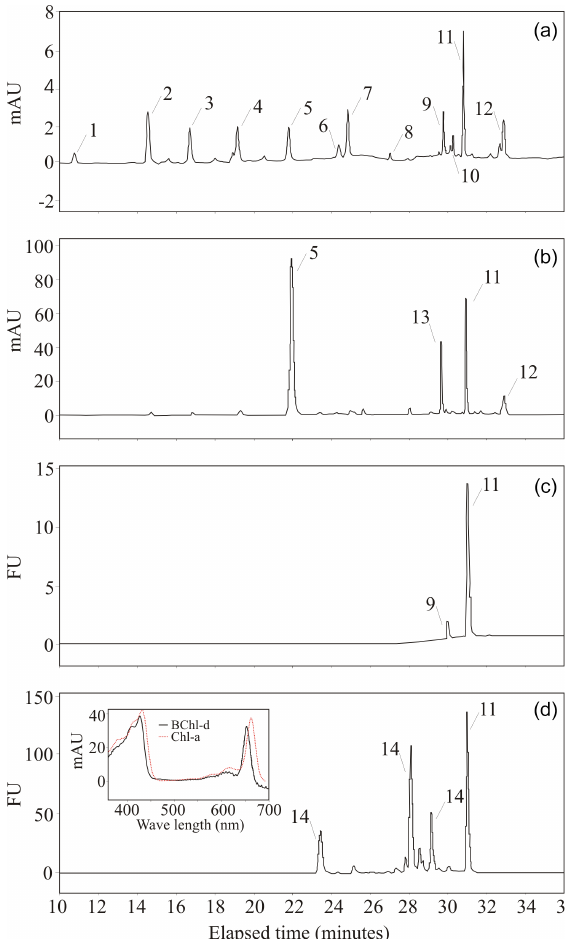
Figure 3. High-performance liquid chromatograms of KWK12 sampled on 3 August 2012: absorbance for the surface (a) or bot- tom (b) water layers and fluorescence for the surface (c) or bottom (d) water layers (mAU denotes measured absorption units; FU de- notes fluorescence units). Pigments from left to right: 1. Perid, 2.